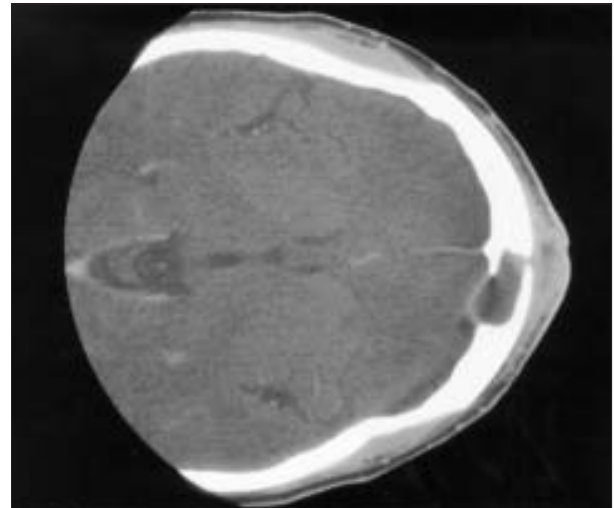
Figure2) Contrast-enhancedcomputedtomography scandemonstrat- ing subgaleal abscess, erosion of anterior and posterior wall of left frontal sinus and small epidural fluid